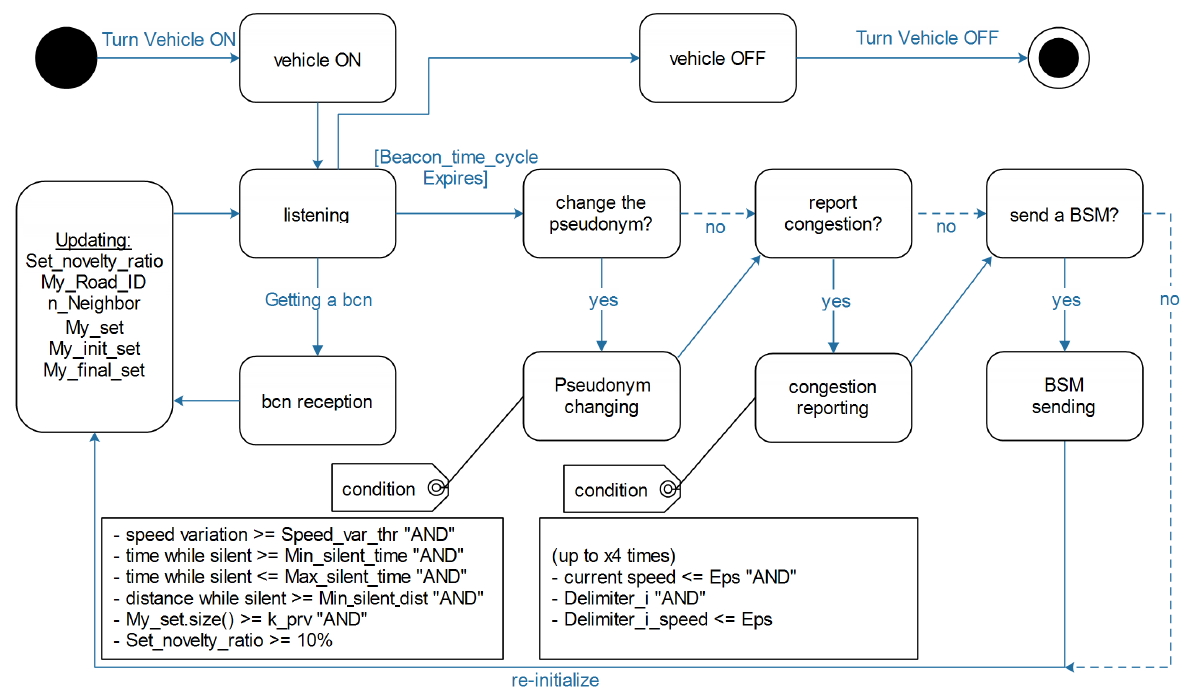
Figure 7. A summarizing state diagram of